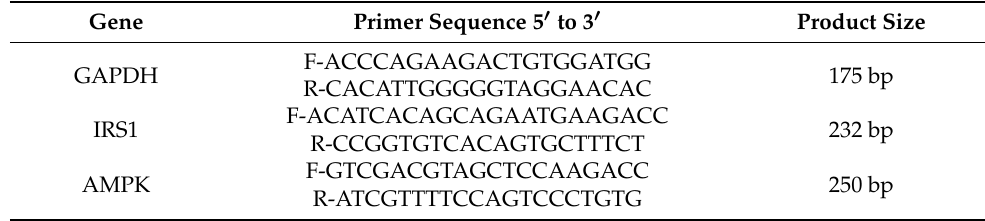
Table 1. Primer sequences used for the expression analysis of AMPK, IRS1, and GAPDH.